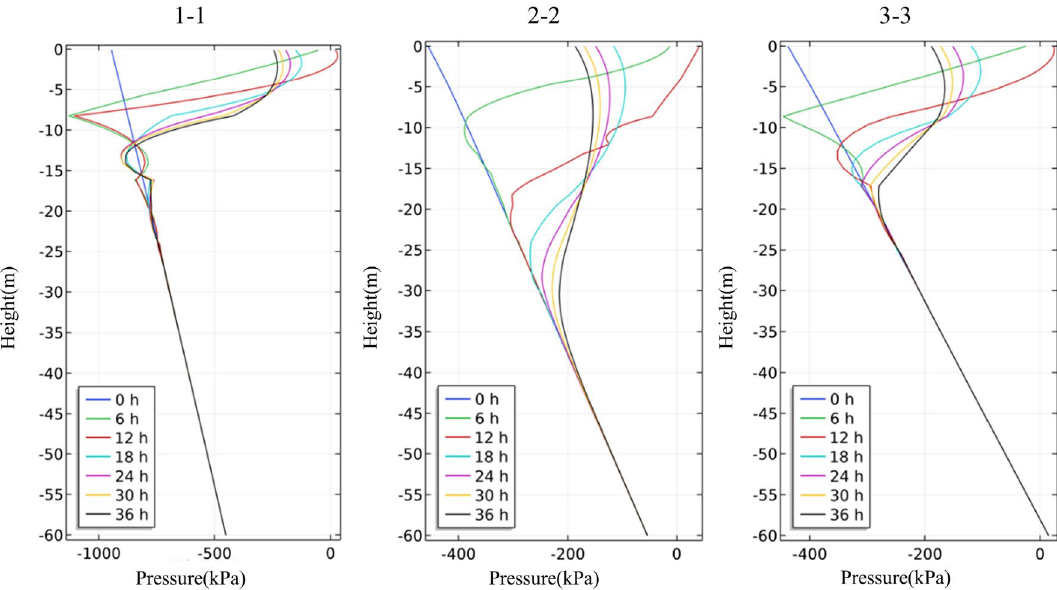
Figure 20. The variation of pore-water pressure in characteristic profiles(Scheme